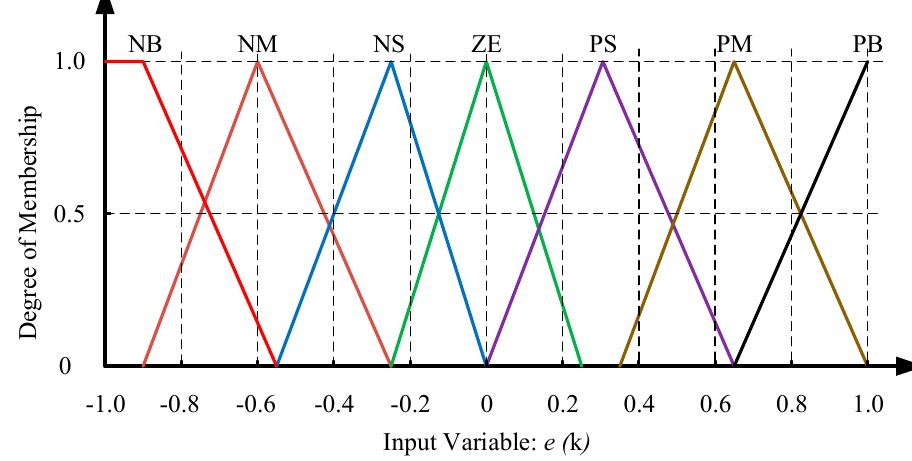
Figure 4. Membership function input error. NB, negative big; NM, negative medium; NS, negative small; ZE, zero; PS, positive small; PM, positive medium; PB, positive big.